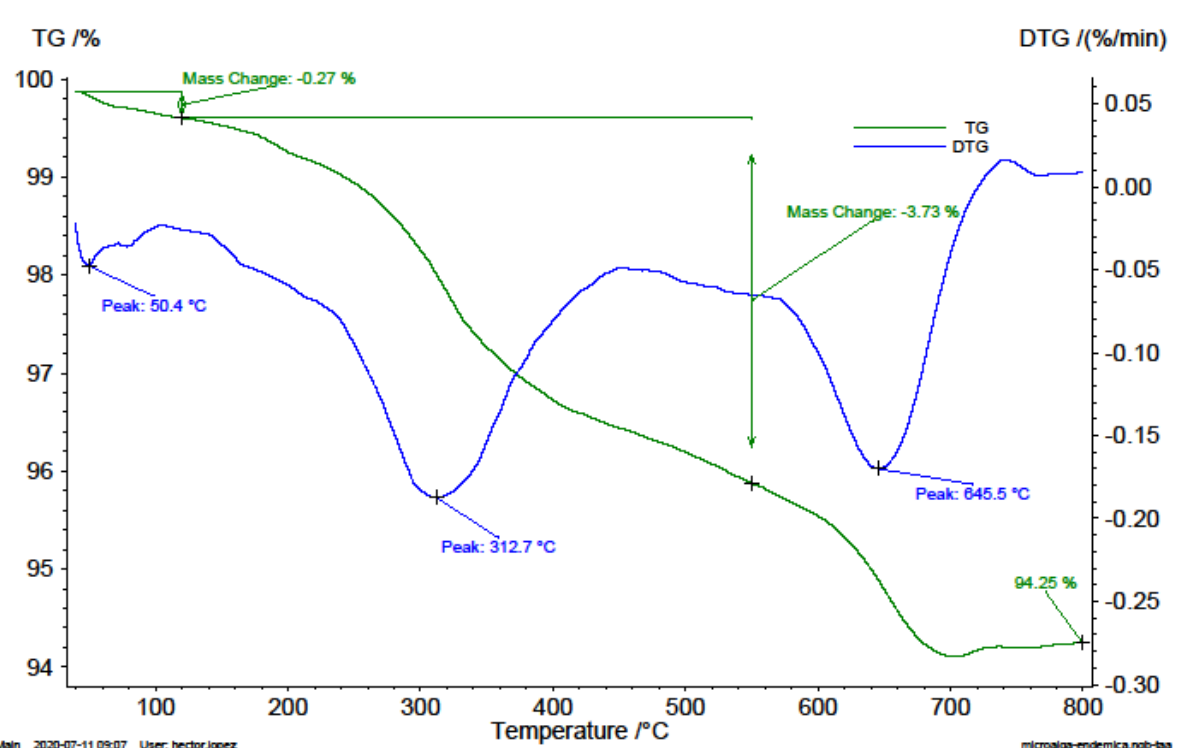
Figure 1. TG an DTG thermograms of endemic microalgae consortium sample (A1).